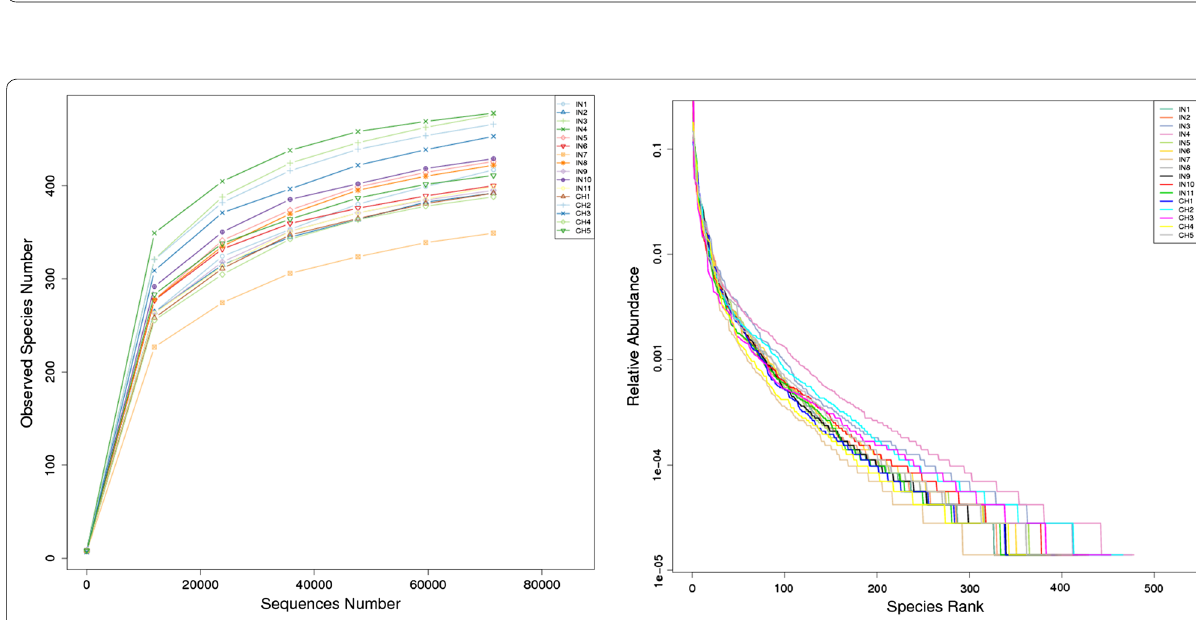
Fig. 4 Rarefaction curves and rank abundance curves of alpha diversity: (Left) in rarefaction curves plot, X-axis is number sequencing reads randomly chosen from a certain sample to obtain OTUs. Y-axis is corresponding OTUs. (Right) in rank abundance curves plot, X-axis is the abundance rank. Y-axis is the relative abundance. Curves for different samples are represented by different